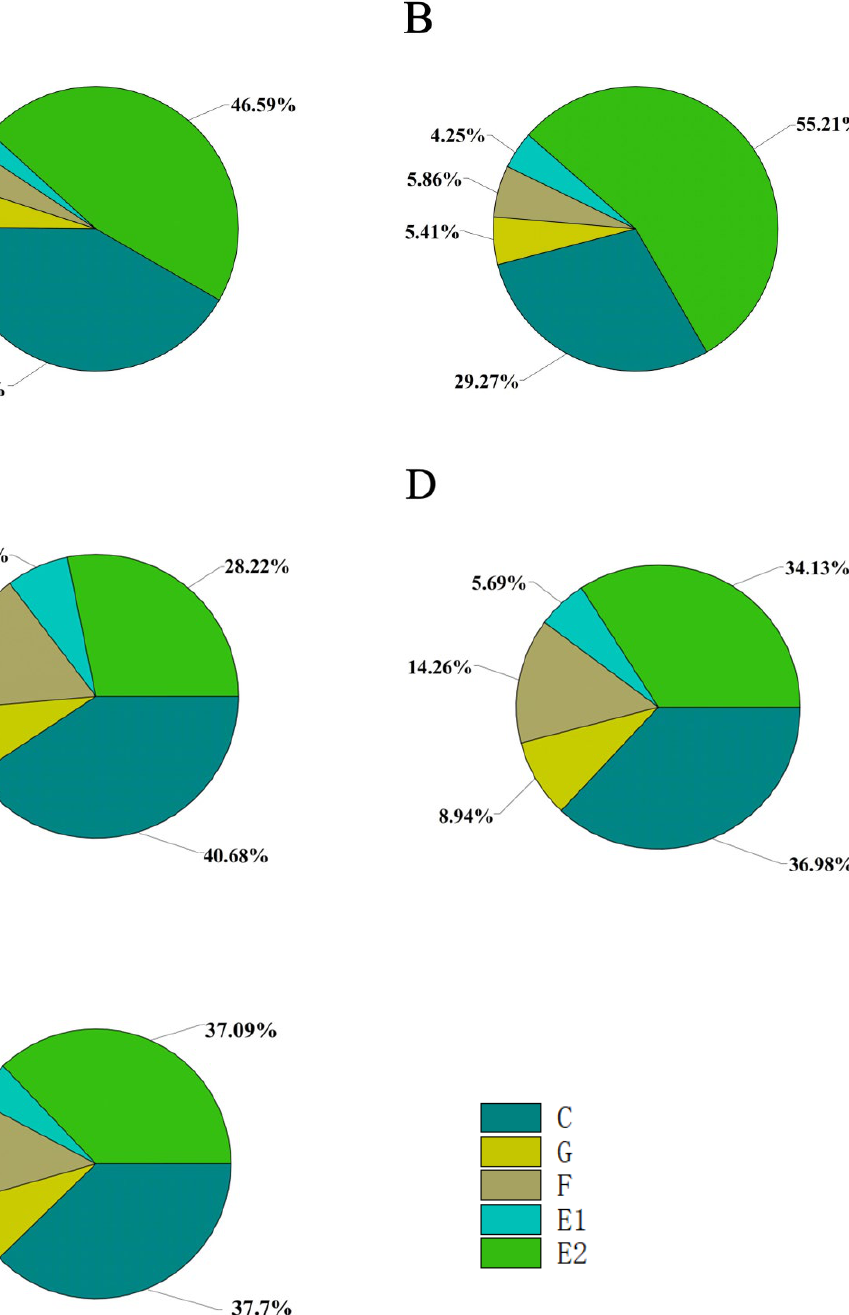
Figure 1. Average percentage of the total time required by M. persicae stylet for feeding on the tissues of five different host plants: tobacco ( A ), radish ( B ), Chinese cabbage ( C ), B. oleracea ( D ), and rape ( E ). The generated EPG waveforms mainly include the following five types: pathway waveforms (C), xylem ingestion (G), derailed stylet mechanics (F), sieve element salivation (E1), and passive phloem ingestion (E2).